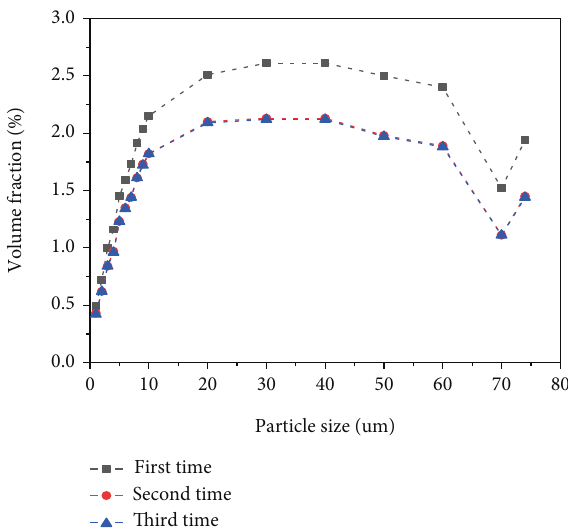
Figure 19: Variation of volume fraction under di ff erent intervals compared with original sample under steel mesh.